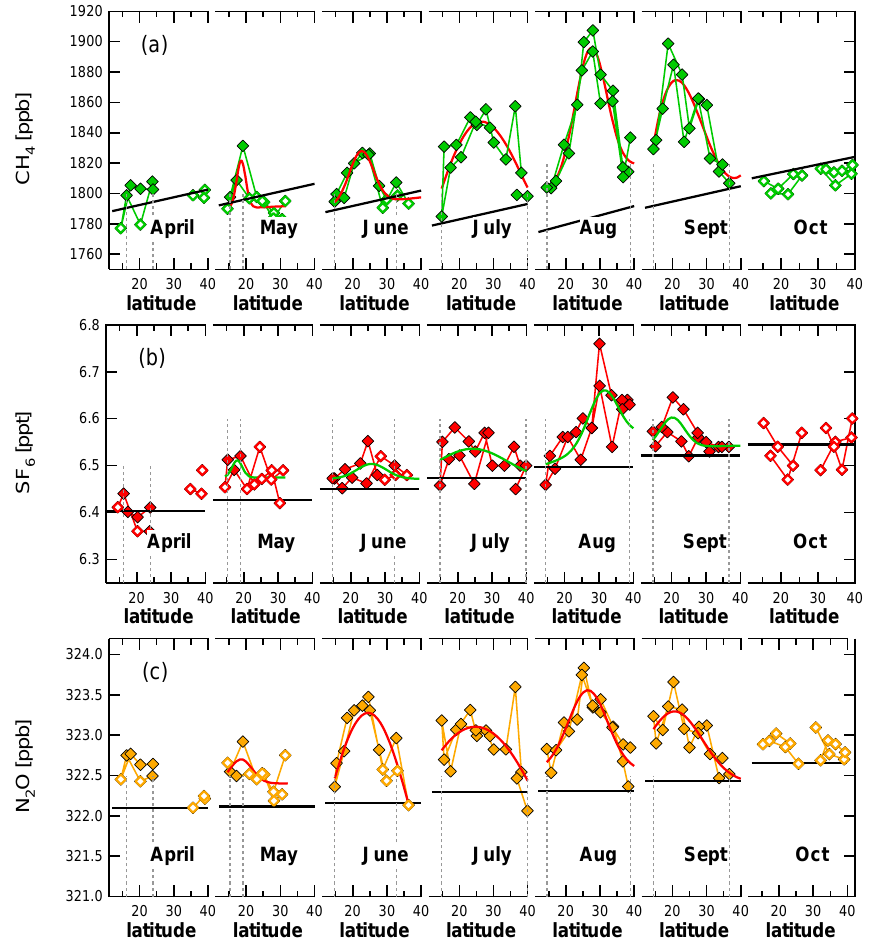
Fig. 8. Latitudinal distributions of CH 4 (a) , SF 6 (b) , and N 2 O (c) for April–October 2008. For May–September a Gaussian has been fit to the data. Solid lines indicate background levels determined from the CARIBIC measurements in April and October for SF 6 and from the Mauna Loa Observatory for CH 4 and N 2 O. All samples for which CH 4 mixing ratios are above the reference background are indicated by closed symbols, open symbols denote samples with lower CH 4 mixing ratios. The vertical dashed lines mark the integration limits used to calculate the increase in the monsoon